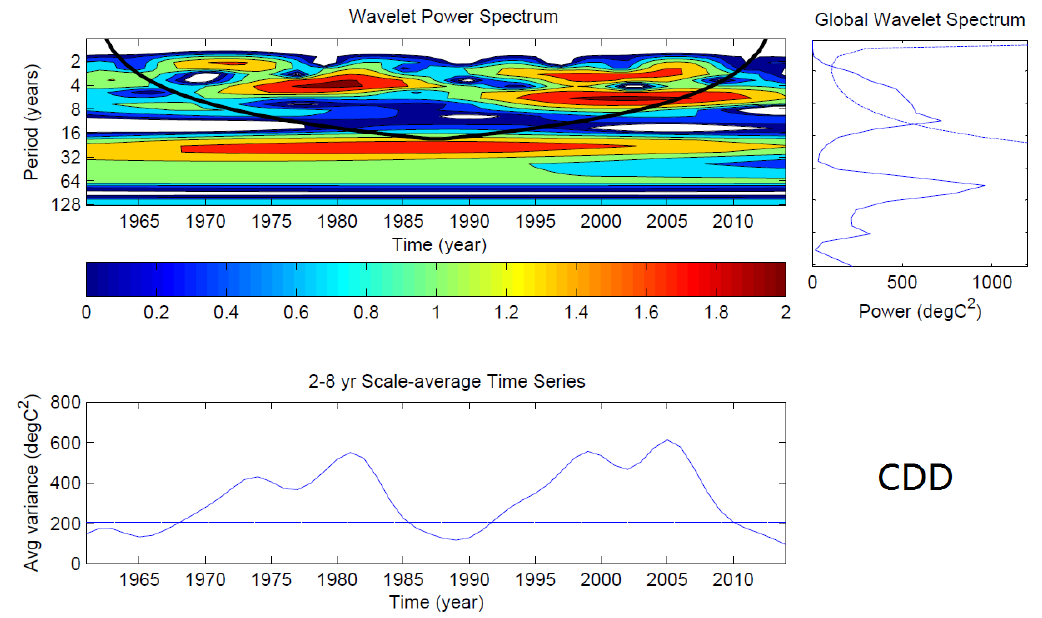
Figure 5. Local and global wavelet spectra for regional average annual CDD time series.